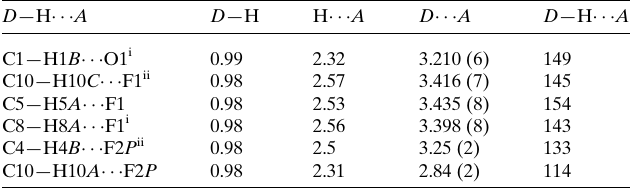
Table 2 Hydrogen-bond geometry (A˚ , (cid:4) ).